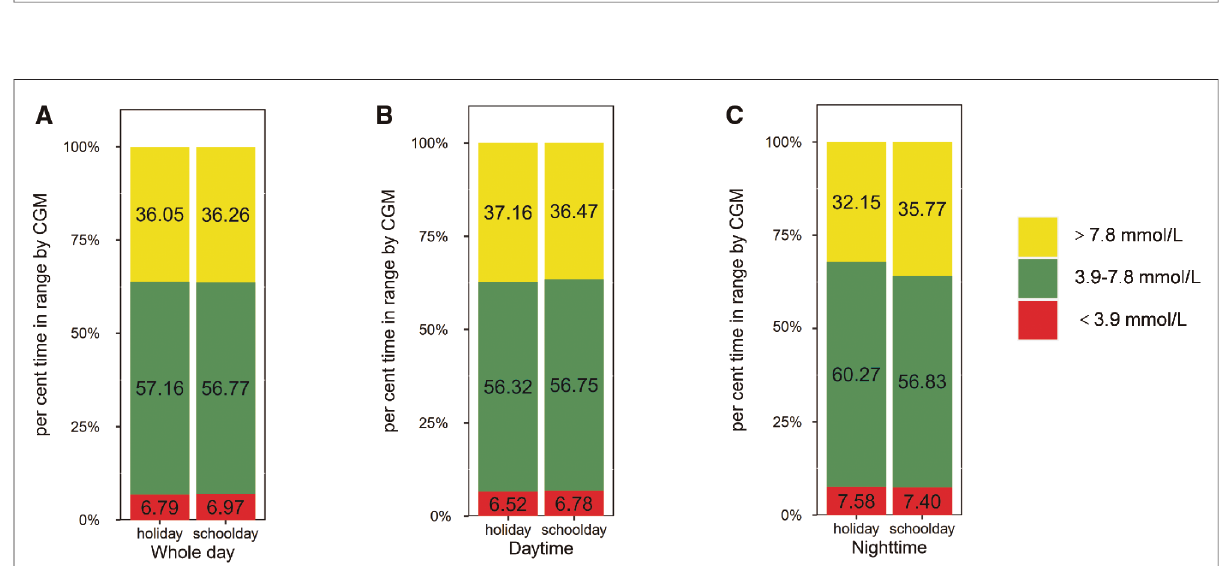
FIGURE 2 Comparison of glycemic metrics in adolescents group: holidays vs. schooldays ( A ) Comparison of 24-hour CGM metrics between holidays and schooldays; ( B ) Comparison of daytime CGM metrics between holidays and schooldays; ( C ) Comparison of nighttime CGM metrics between holidays and schooldays; CGM, Continuous glucose monitoring; TIR 3.9 – 7.8, The time spent in target glucose range between 3.9 – 7.8 mmol/L; TAR 7.8, the proportion of time spent with glucose levels above 7.8 mmol/L; TBR 3.9, The proportion of time spent with glucose levels below 3.9